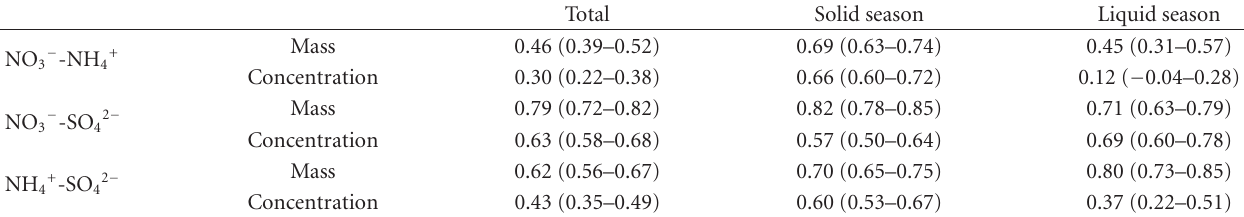
Table 2: Pearson correlation coe ffi cients of nitrate, ammonium, and nss-sulphate for the complete precipitation year, solid- and liquid season. The values in brackets show the 0.95 confidence interval.